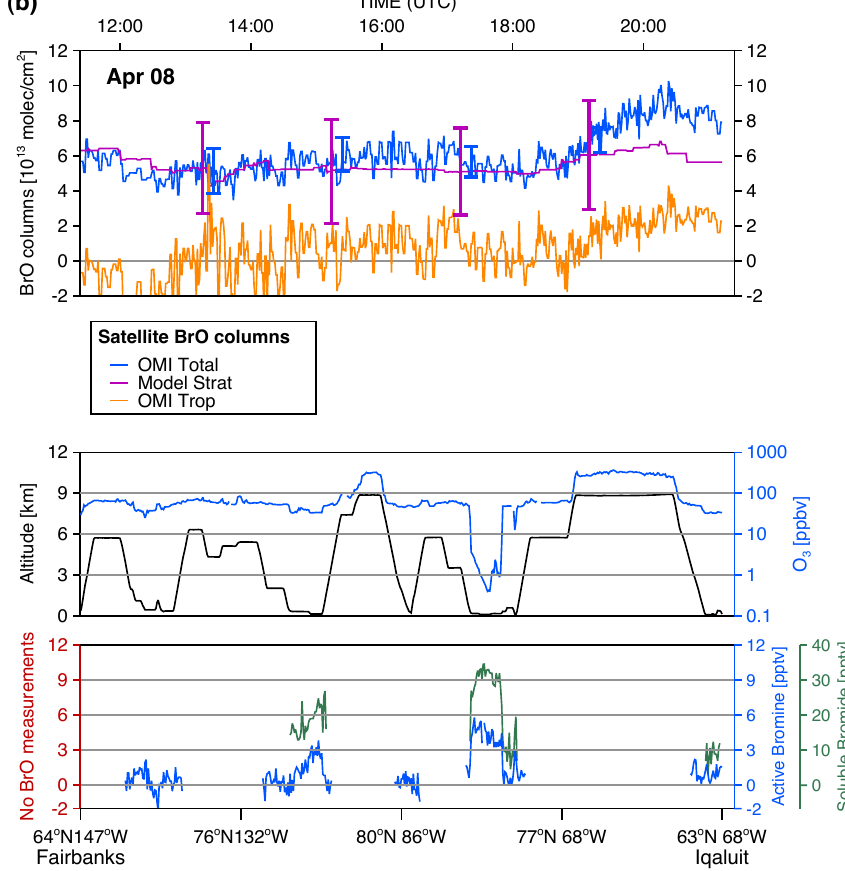
Fig. 8b. Similar to Fig. 7b but for the DC-8 flight on 8 April 2008.